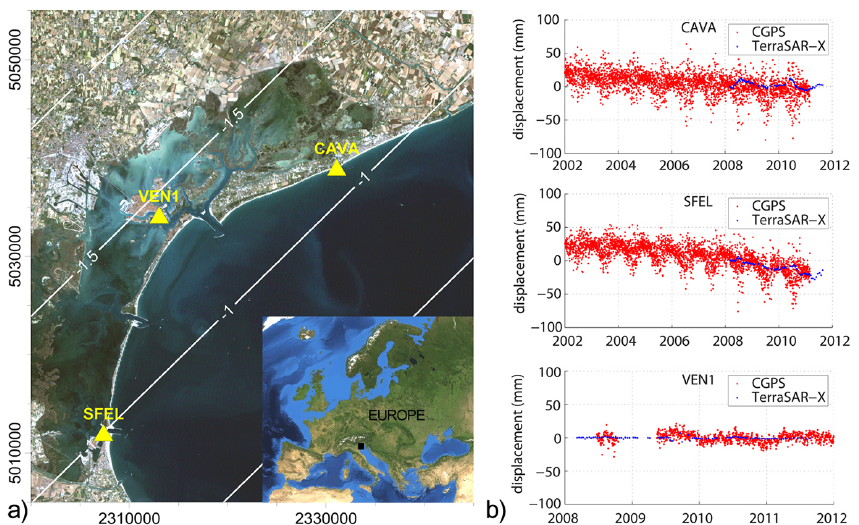
Figure 1. (a) Data calibration: plane model based on the Venice (VEN1), Chioggia (SFEL), and Cavallino (CAVA) CGPS displacements, used to correct the PSI outcome. (b) Comparison between the CGPS and the calibrated PS time